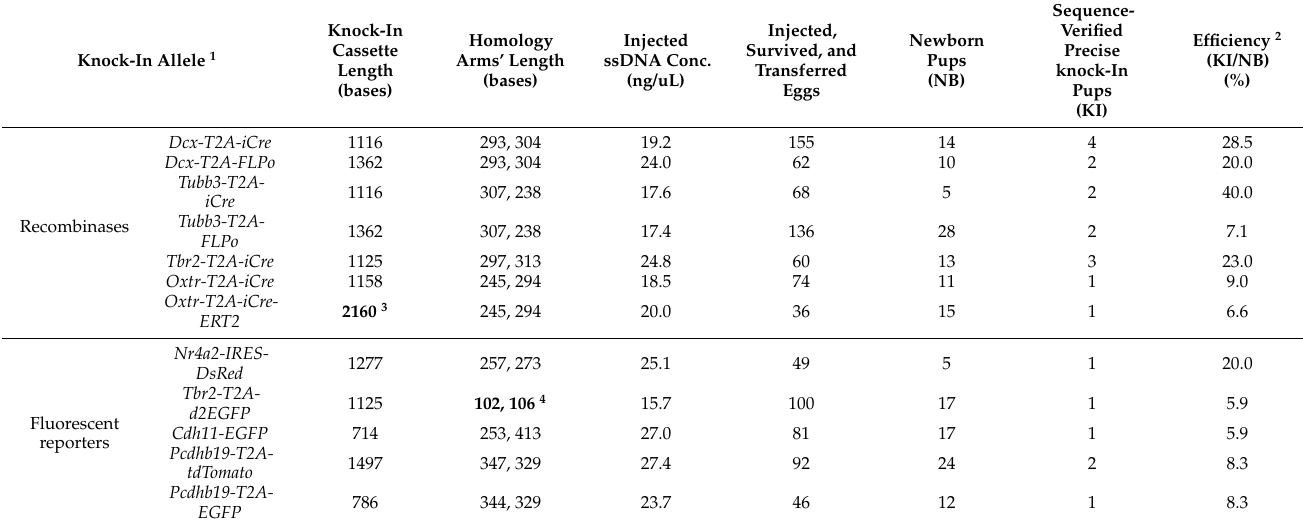
Table 2. Summary of knock-in mouse generations by using the phospho-PCR-mediated long ssDNA donors.